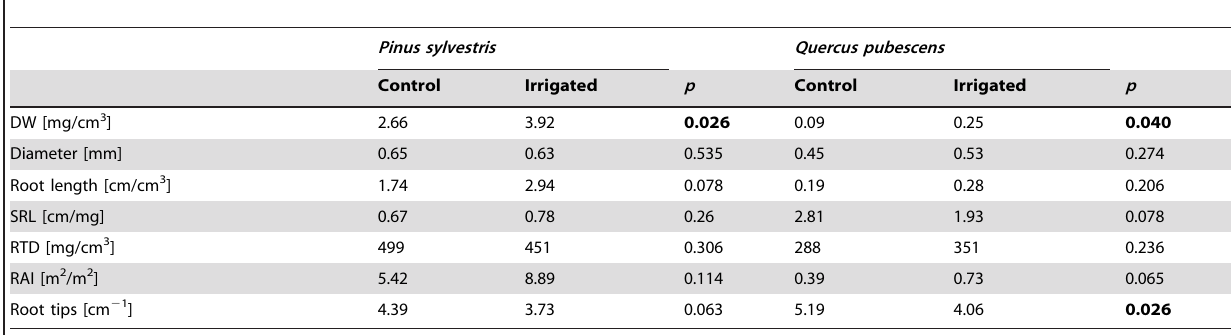
Table 3. Morphological properties of Pinus sylvestris and Quercus pubescens fine roots after nine years of irrigation.